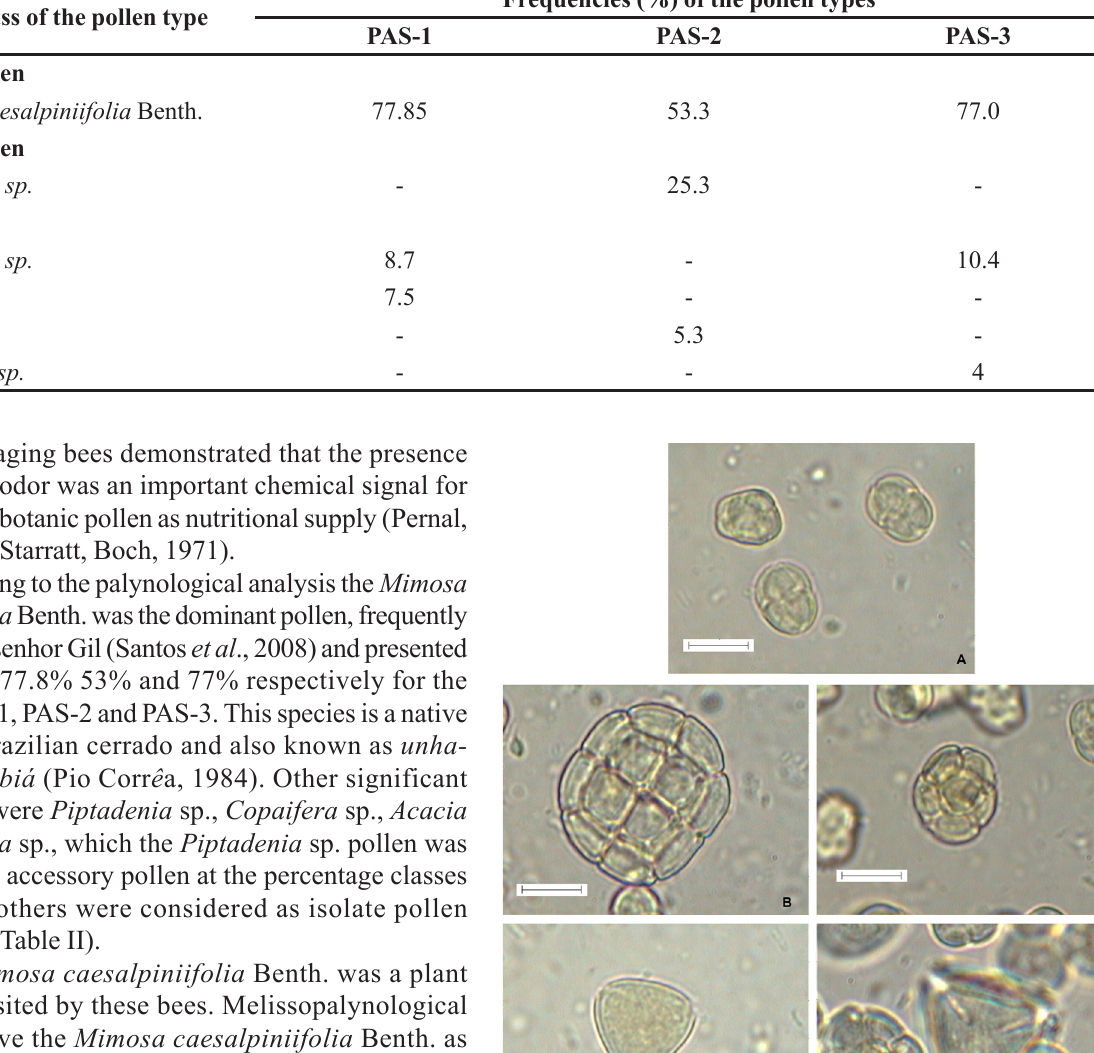
TABLE II - Main pollen types identified in three samples of stingless bee pollen of the genus Scaptotrigona sp. from Monsenhor Gil, Piaui, Brazil, collected at December 2006 (PAS-1), March 2006 (PAS-2) and July 2006 (PAS-3) Percentage class of the pollen type